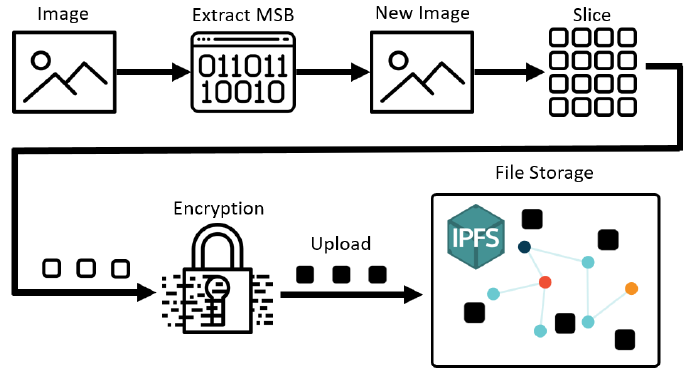
Figure 6. Process of image slicing and encryption.